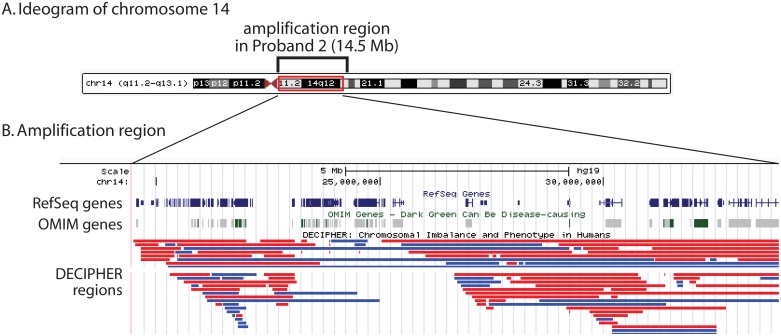
Region of segmental trisomy on chromosome 14 in proband 2.(A) The region spans 14.5 Mb (GRCh37/hg19 chr14:19,487,381–33,947,341). (B) The amplification region includes 404 RefSeq genes. Additional tracks show DECIPHER regions of chromosomal imbalances (deletions in red, duplications in blue) and OMIM disease genes.